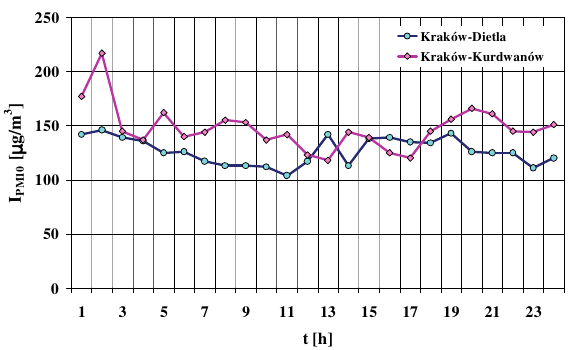
Fig. 2. The immission of particulate matter PM10 on 6 January 2016 In most part of the day the immission of particulate mat- ter PM10 is significantly higher on Kraków–Kurdwanów